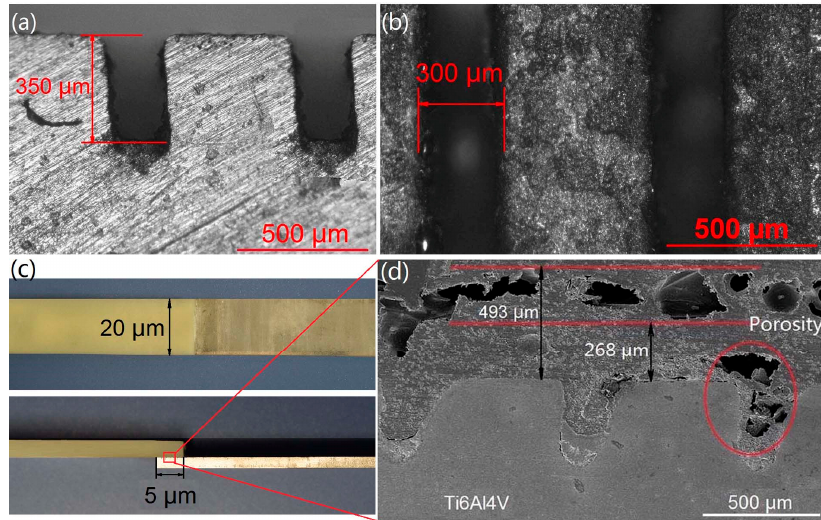
Figure 3. ( a )–( b ) Laser created groove structures on Ti6Al4V surface with depth of around 350 μ m ( a ) and width of around 300 μ m ( b ); ( c ) images of LAMP produced Ti6Al4V-PA66-GF30 specimen; ( d ) cross-section of LAMP produced Ti6Al4V-PA66-GF30 joint. The other type of pores distributes close to the boundary of melted zone and has a distance of around 200-500 μ m from Ti6Al4V-PA66-GF30 bonding interface [15], as indicated in Figure 3d and